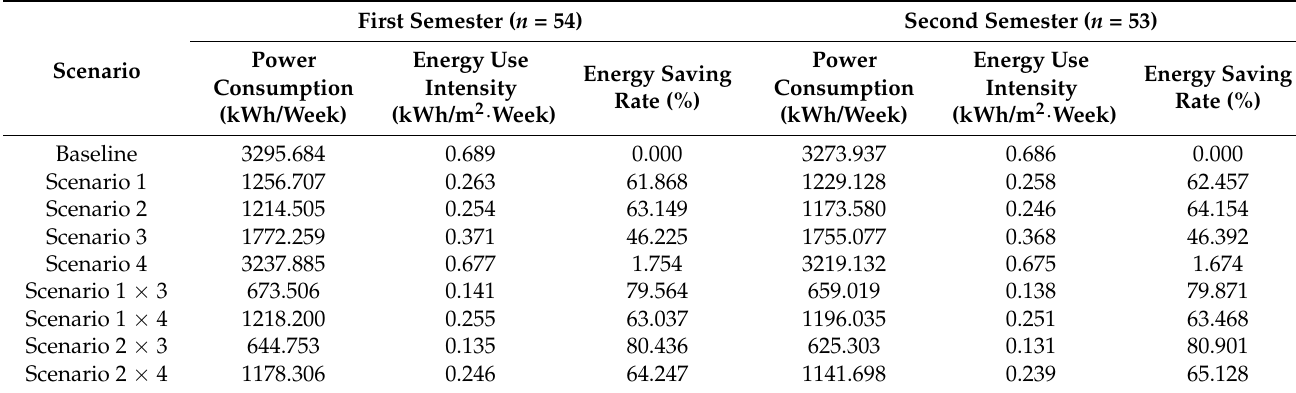
Table 3. Electric power consumption by